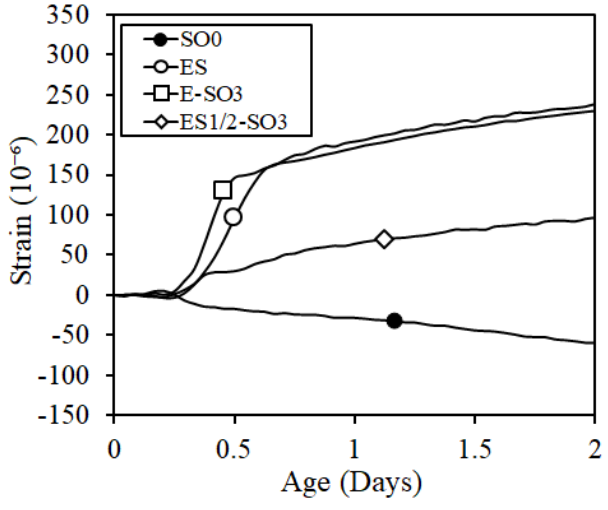
Figure 11. Expansion rate.